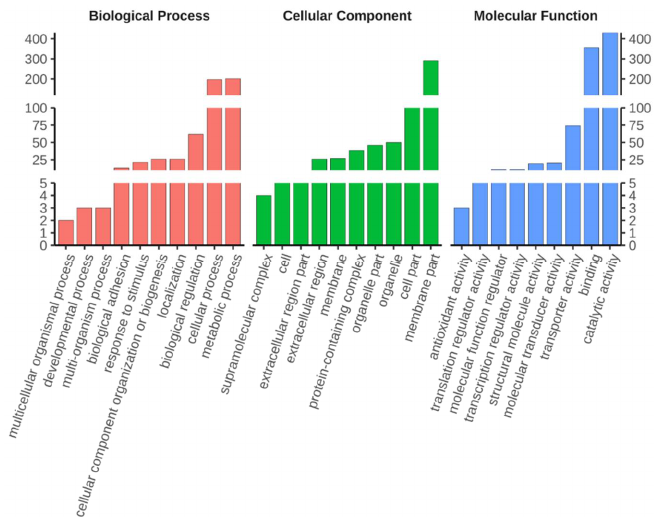
Figure 2. Gene ontology (GO) terms that were significantly enriched in shared DEGs upon diapause termination. The GO terms containing the top ten number of DEGs (with ties) within three GO annotation categories (stated at the top of the image) are shown. The y -axis indicates the number of DEGs.